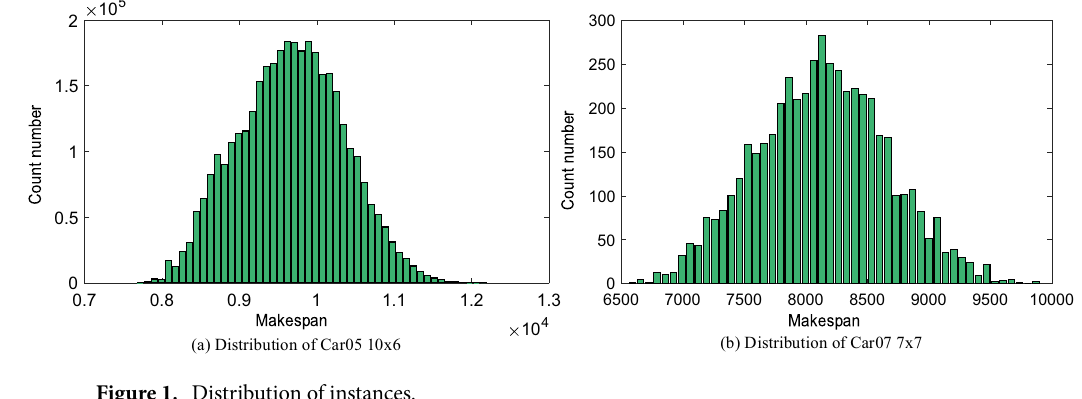
Figure 1. Distribution of instances.